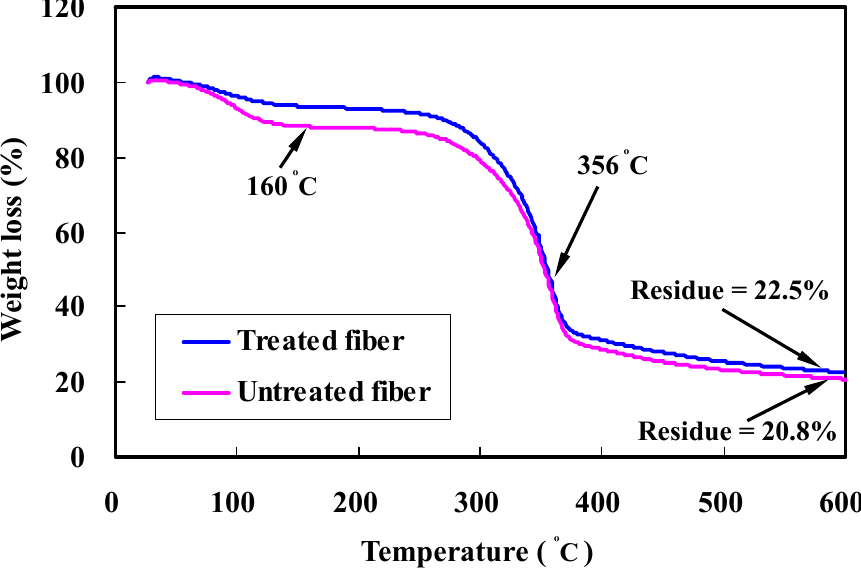
Figure 5. TGA curve of untreated and alkali treated bamboo fibers.